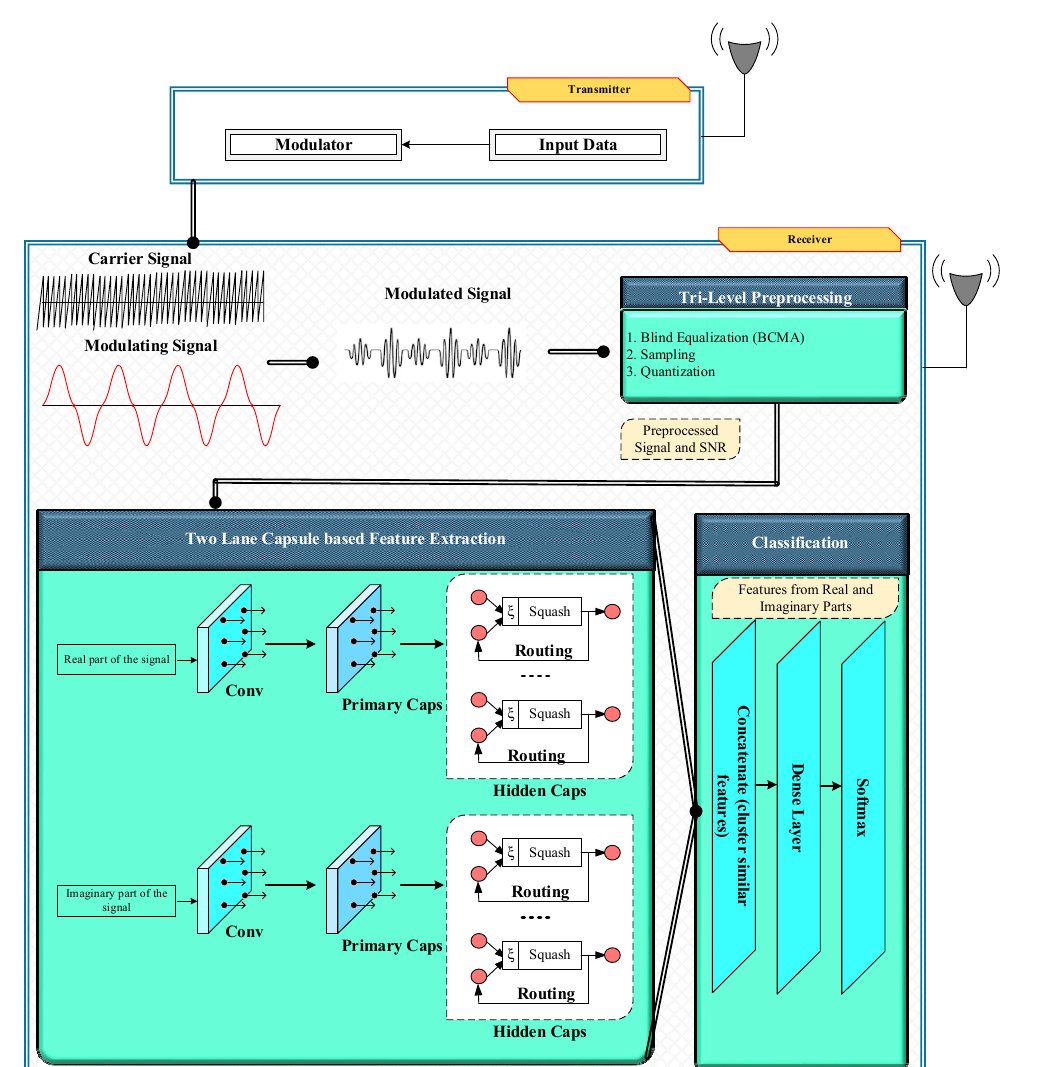
Figure 3. Architecture of the proposed automatic modulation classification using a feature clustering-based two-lane cap- sule network (AMC2N) method.